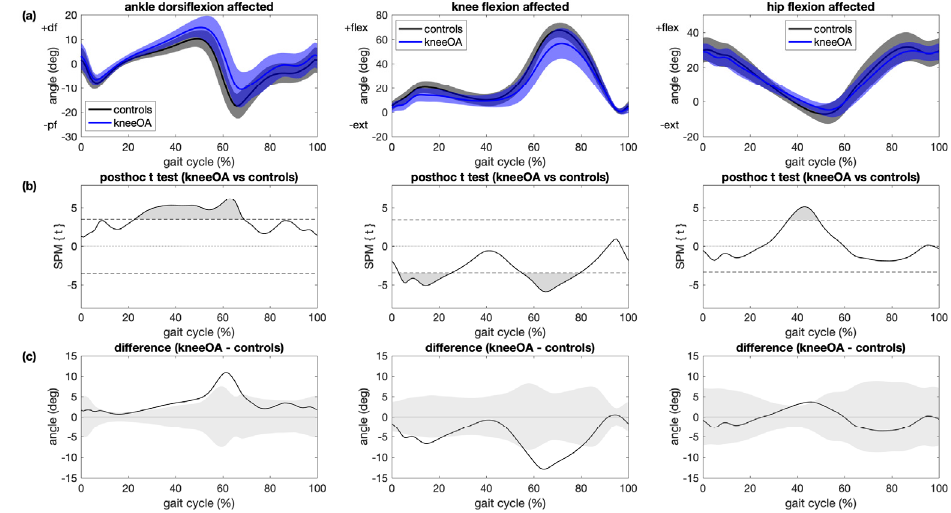
Figure 2. Comparison between patients with knee OA and controls. ( a ) Mean and 1 standard deviation joint angle trajectories for ankle dorsiflexion (left), knee flexion (center) and hip flexion (right) angle for the affected/left leg for patients with knee OA (blue) and controls (black); ( b ) results of statistical parametric mapping with posthoc t tests (SPM{t}) where regions with statistically significant difference between groups are indicated as grey regions ( p < 0.05/3); ( c ) mean joint angle deviation from the control group for patients with knee OA where grey areas illustrate ± 1 SD of the joint angles of the control group.